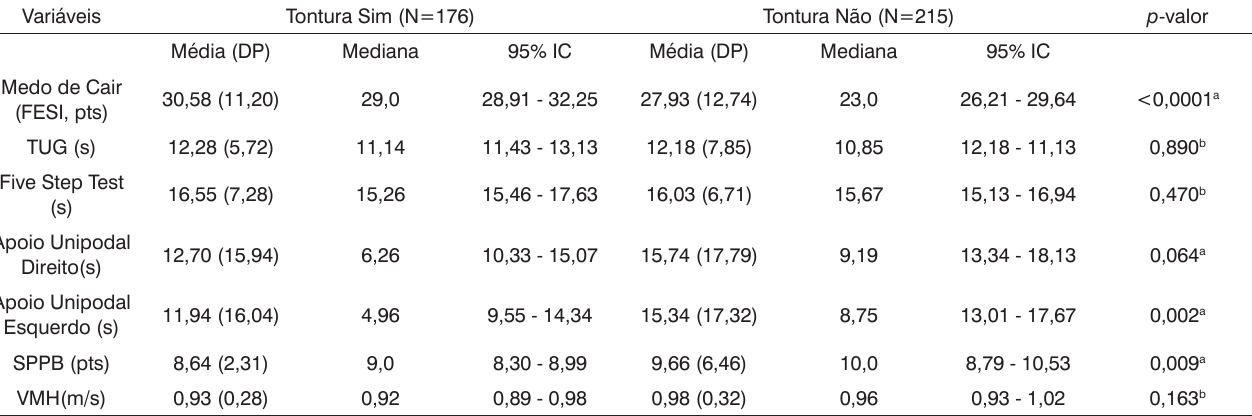
Tabela 3. Caracterização do desempenho físico funcional e do medo de cair em idosos com e sem queixa de tontura (N=391) residentes na